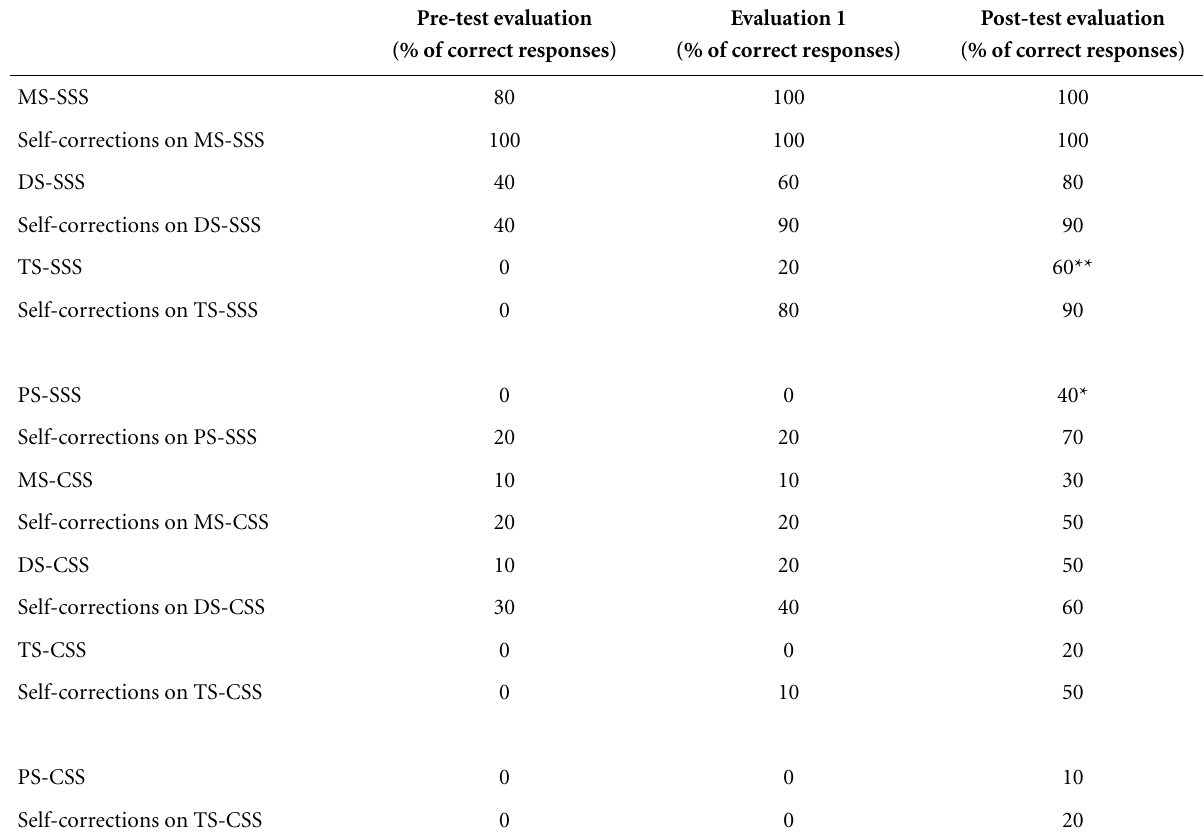
Table 1. Performance of OCS on the Complementary Test 2 – Efficacy of the treatment.